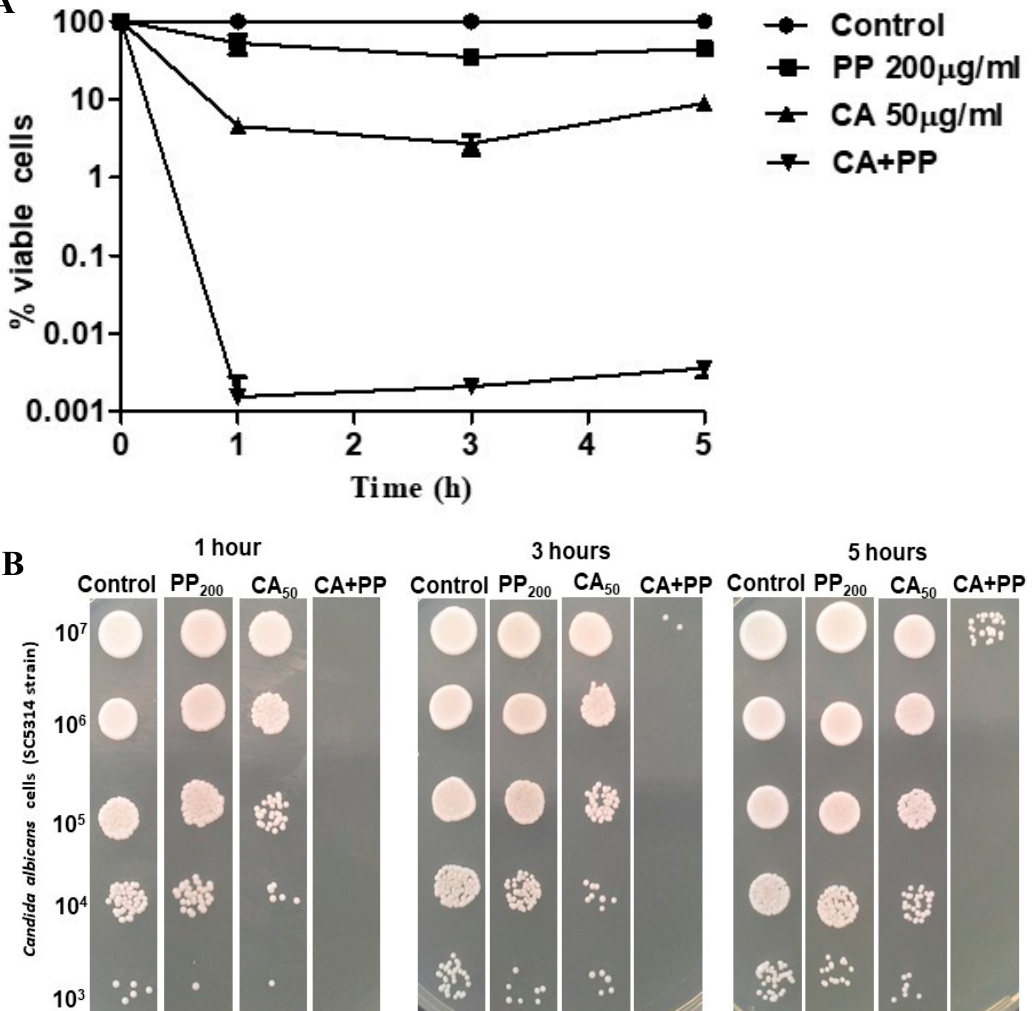
Figure 2. Time-course evolution of cell viability (%) after the addition of 50 µg/mL CA and 200 µg/mL PP, either separately or combined, to cultures of SC5314 strain growing on YPD. After incubation for 1 h at 37 °C, identical samples were harvested and washed at the indicated periods and the percentage of surviving cells in liquid medium ( A ) or the formation of colonies on solid plates ( B ) was determined. The experiments were repeated three times with consistent results. For other details, see Figure 1.